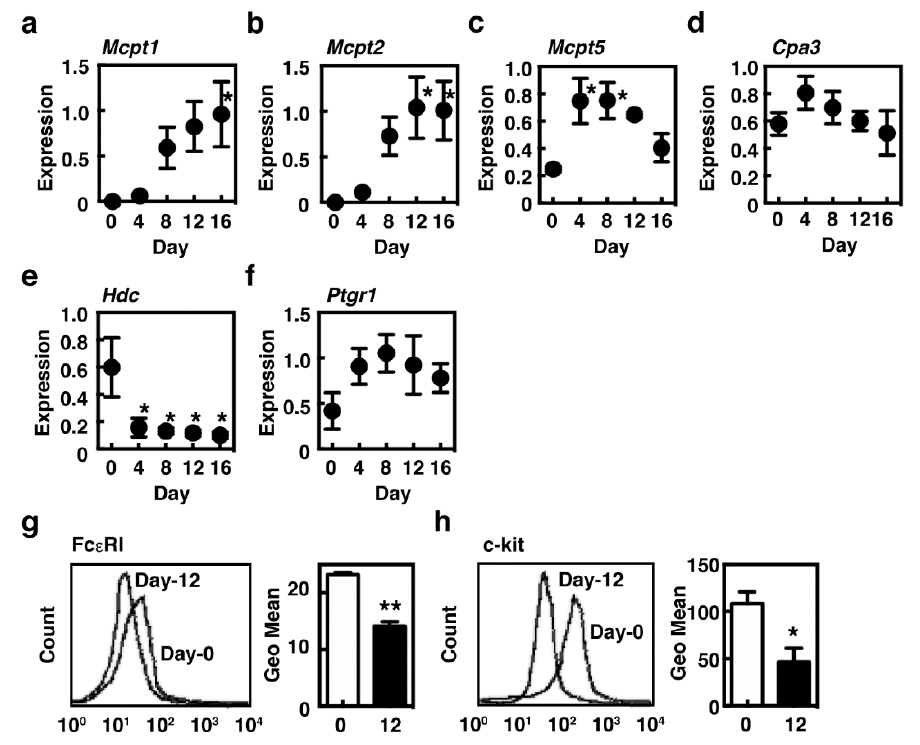
Figure 1. Induction of the characteristic genes of mucosal mast cells in the presence of interleukin-9 (IL-9) and stem cell factor (SCF). ( a – f ) Bone-marrow-derived cultured mast cells (BMMCs) were cultured in the presence of 10 ng / mL IL-9 and 30 ng / mL SCF for 16 days. Expression levels of mRNA of ( a ) Mcpt1 , ( b ) Mcpt2 , ( c ) Mcpt5 , ( d ) Cpa3 , ( e ) Hdc and ( f ) Ptgr1 were measured by quantitative RT-PCR. The expression levels were normalized by measuring mRNA expression of Gapdh . The values are expressed as the means ± SEM ( n = 3). Multiple comparisons were performed using one-way ANOVA with the Dunnett post-test. Values with * p < 0.05 are regarded as significant (vs. day 0). ( g , h ) Surface expression levels of ( g ) Fc ε RI and ( h ) c-kit of BMMCs (day 0, open columns) and MCs / IL-9 (day 12, closed columns) were measured by flow cytometry as described in Section 4. The mean fluorescence intensities are shown as the means ± SEM ( n = 3, right panels). Statistical analysis was performed using Student’s t -test. Values with * p < 0.05 and ** p < 0.01 are regarded as significant.